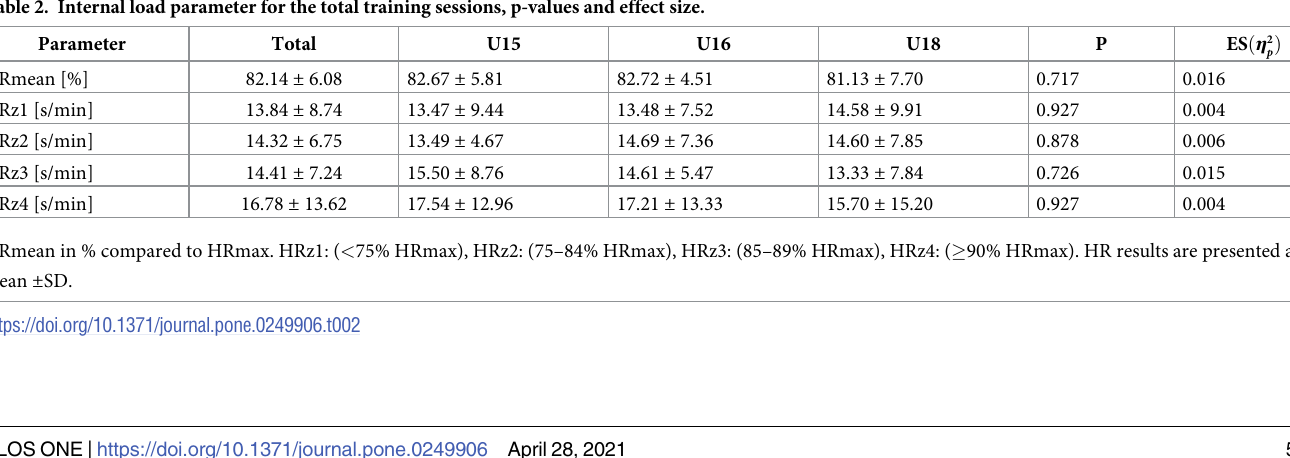
Tables 1 and 2 demonstrate results for EL-parameters and IL-parameters respectively. Results are presented with regard to age groups and total training sessions. Statistically significant dif- ferences were identified between age groups for distance covered in SZ 1, low-intensity-run-